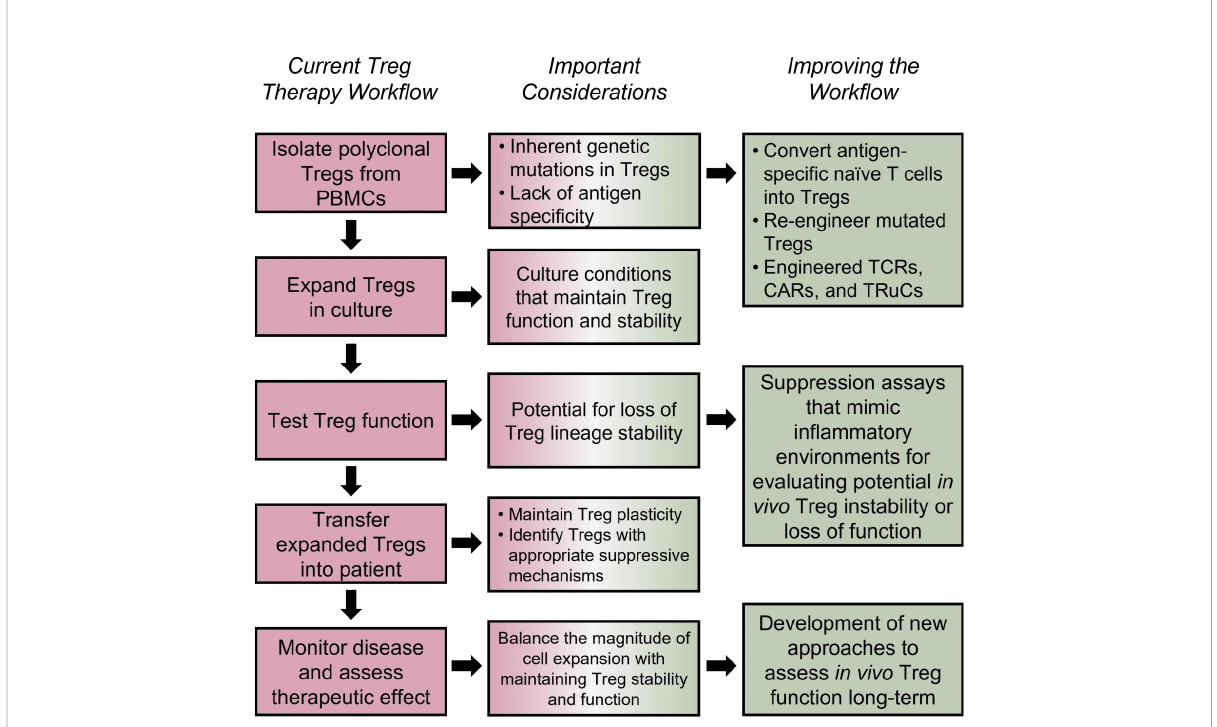
FIGURE 4 Tailoring Treg therapies for improved ef fi cacy. Using human autologous Tregs is a promising approach for treatment of autoimmune and in fl ammatory disorders (196); however, the ef fi cacy of such approaches depends on several factors. Loss of Treg suppressive capacity, stability, or stemness could be a side effect of in vitro expansion protocols (205 – 207). The potential inherent defects in Tregs, lack of antigen speci fi city (208 – 211), TSDR methylation status post expansion (206), and long-term functionality must also be considered. Potential solutions